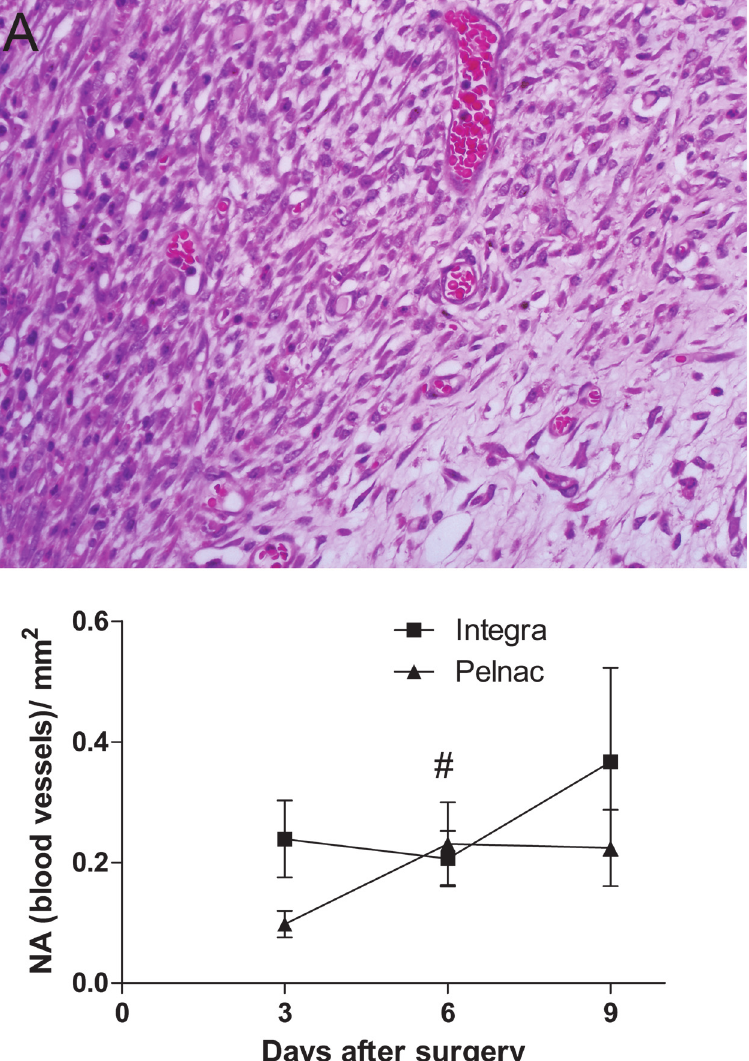
Fig 4. Histological aspects of wounds treated with dermal substitutes showing vascular density. (A) Representative picture of HE-stained transversal section of a full-thickness skin wound with emphasis in blood vessels. (B) Quantification of blood vessels during the 9 days after the surgical procedure. NA numerical density that represent the number of blood vessels per mm 2 . Data are expressed as the mean ± SEM of 5 animals. Not significant differences between the two templates were observed at any time point. # p = 0.05 Pelnac at the day 3 vs . Pelnac at day 6 by two-tailed unpaired t-test. Original magnification 400X.